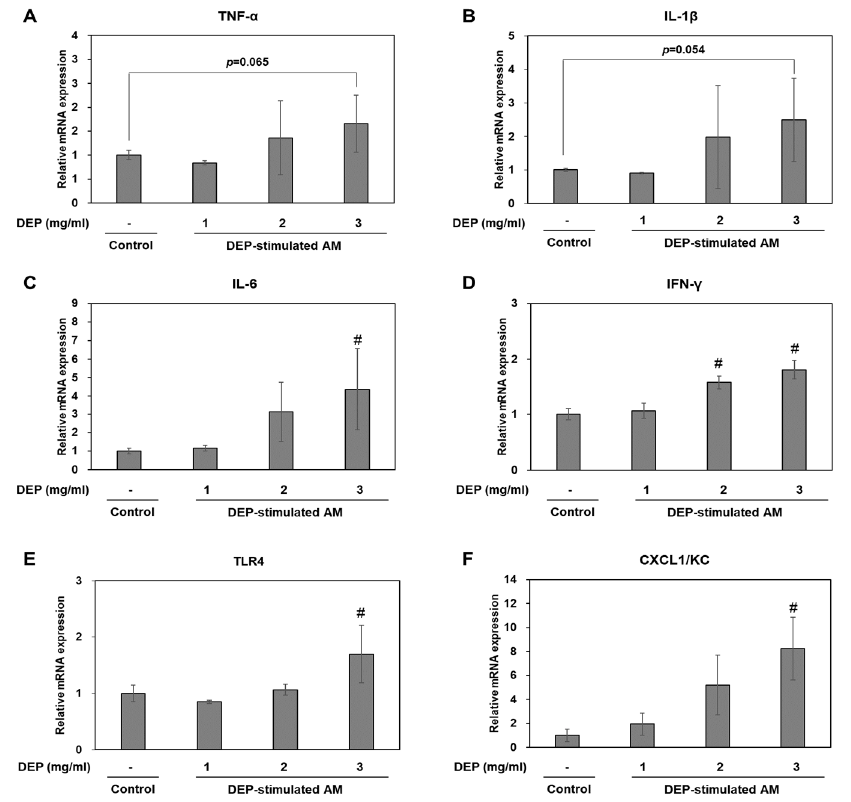
Figure 6. ( A – F ) Relative mRNA expression levels for inflammatory factors in DEP-stimulated AM. Data are means ± SD ( n = 3 per group). # p < 0.05 vs. control.